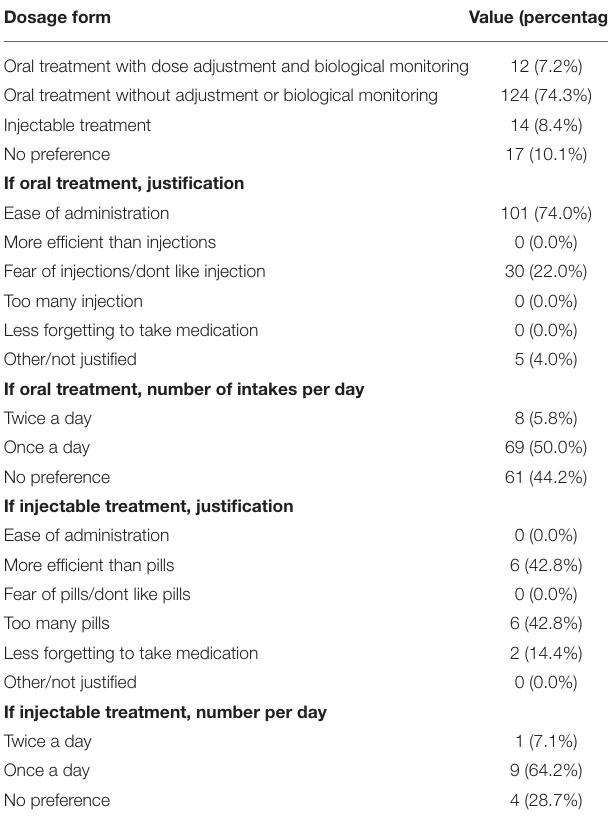
and number of intakes per day. Dosage